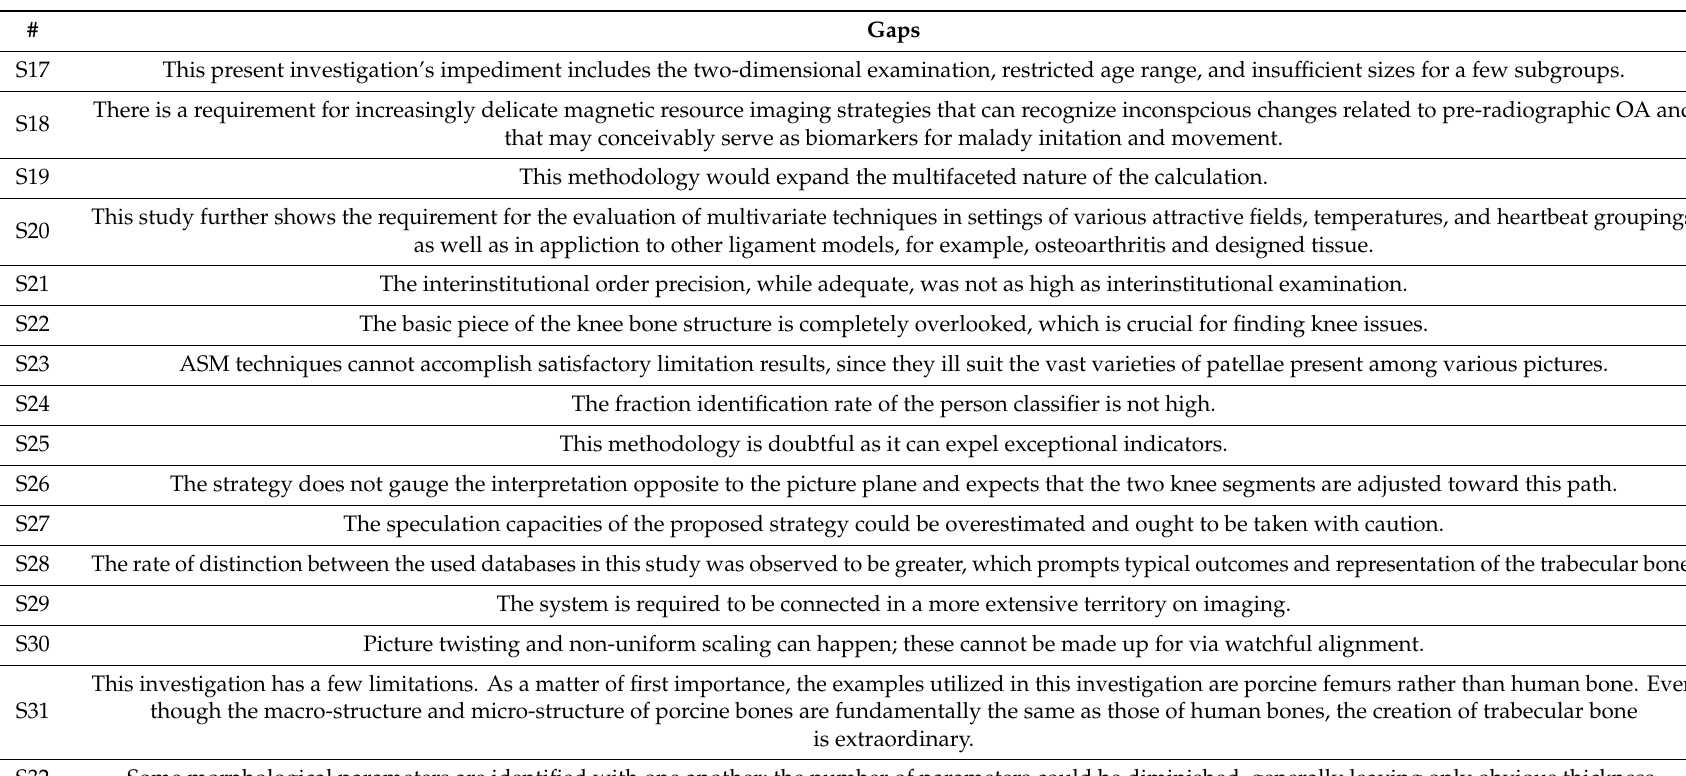
Table 14. Gaps in machine learning